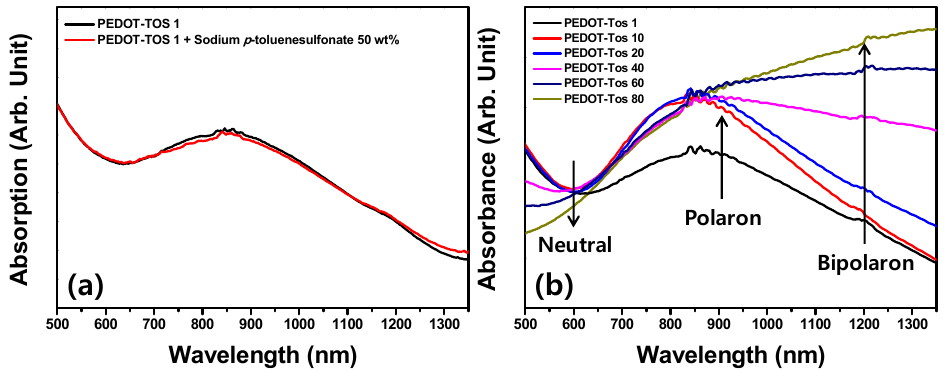
Figure 4. Ultraviolet-visible-near-infrared (UV-Vis-NIR) absorption spectra of PEDOT-Tos (1 mg · mL − 1 dispersed in n -butanol) are plotted. ( a ) PEDOT-Tos 1 synthesized with a small concentration of the oxidant (1 wt %), which cannot be doped more than the intrinsic level by excess sulfonate (sodium p -toluenesulfonate). ( b ) Peaks increasing with the concentration of the oxidant used for the synthesis of PEDOT-Tos are observed at approximately 1200 nm (bipolaron state) in the absorption spectra.